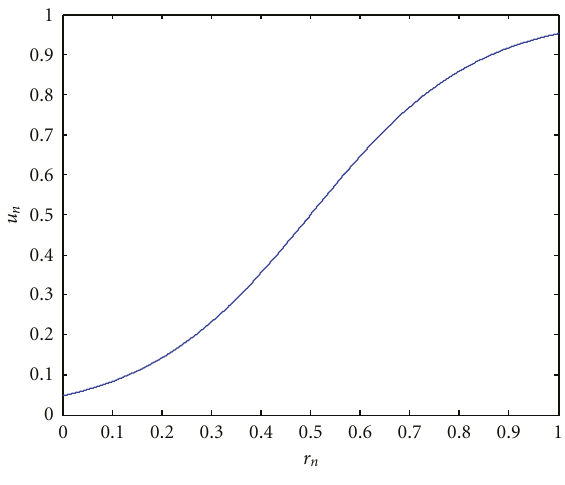
Figure 4: A sigmoid utility